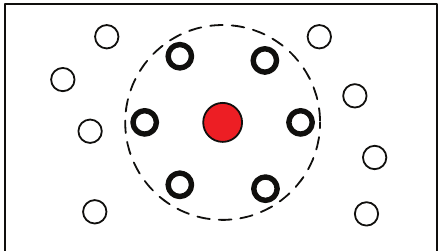
Figure 3: The topology of group animals in the